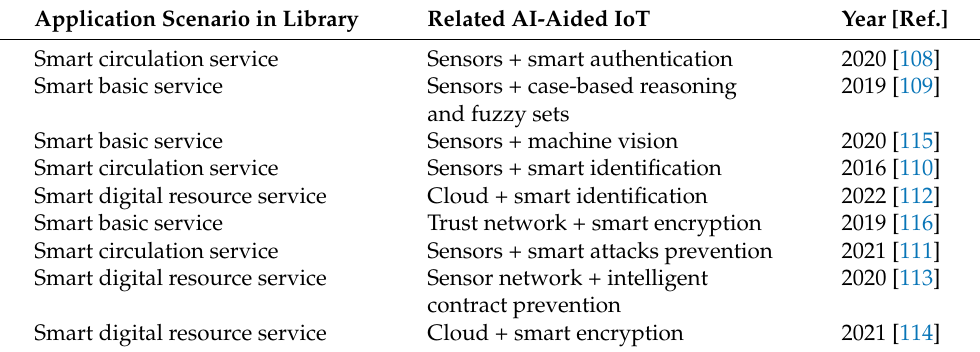
Table 4. The surveyed literature on AI-aided IoT applied in smart library